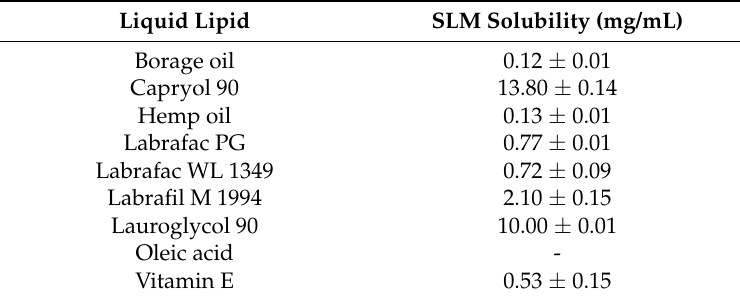
Table 1. Solubility of silymarin (SLM) in different liquid lipids/oils. Results are expressed as means ± standard deviation, n =